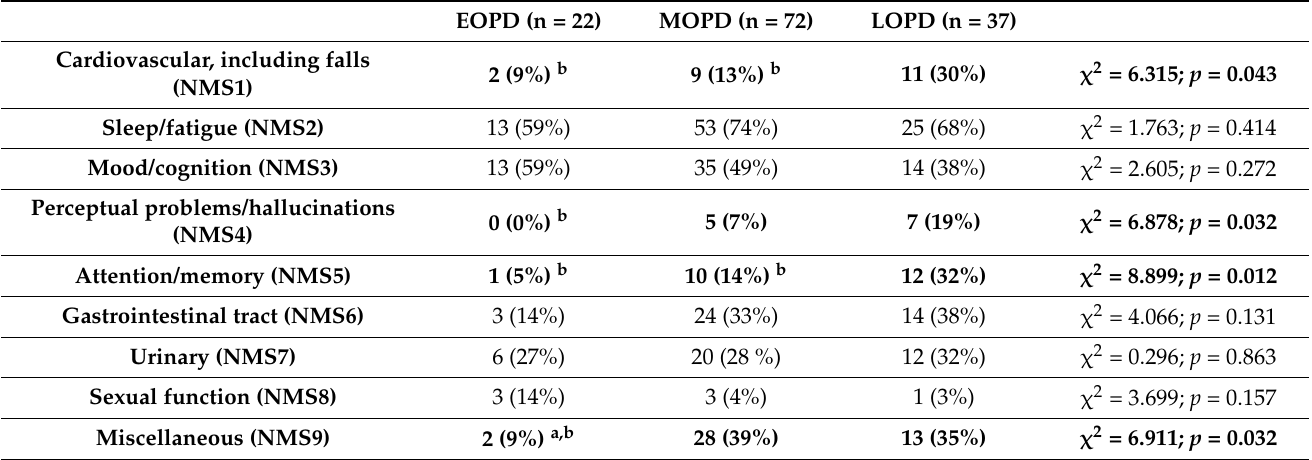
Table 2. NMSS domains reported as present in the investigated population and comparisons across age groups at T1. Significant results of chi-squared test are highlighted in bold. Significant results at baseline are highlighted in bold. Significant pairwise post hoc comparisons are shown by superscript letters, as indicated in the legend at the bottom of the table. EOPD: Early-Onset-PD; MOPD: Middle- Onset-PD; LOPD: Late-Onset-PD; NMSS: Non-Motor Symptoms Scale; PD: Parkinson’s disease. EOPD (n =